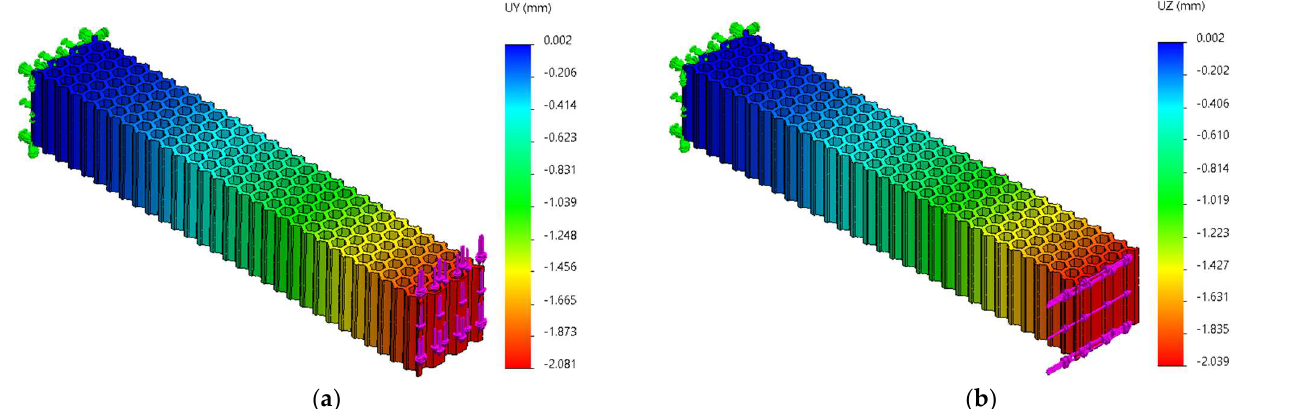
Figure 22. Cantilever beam. The displacement charts for the hexagonal structure: ( a ) α = 0 ° , ( b ) α = 90 ° .